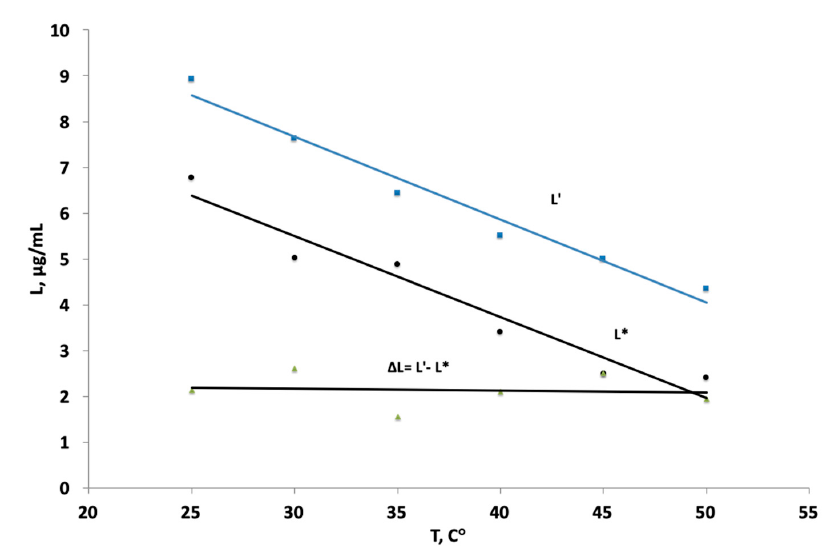
Figure 8. Temperature-dependent ligand binding in DNApol β -HL60 / Poly(dT) 50 pair. L’—DNApol β , receptor; L*—HAS, receptor (control). For technical details, see Methods .